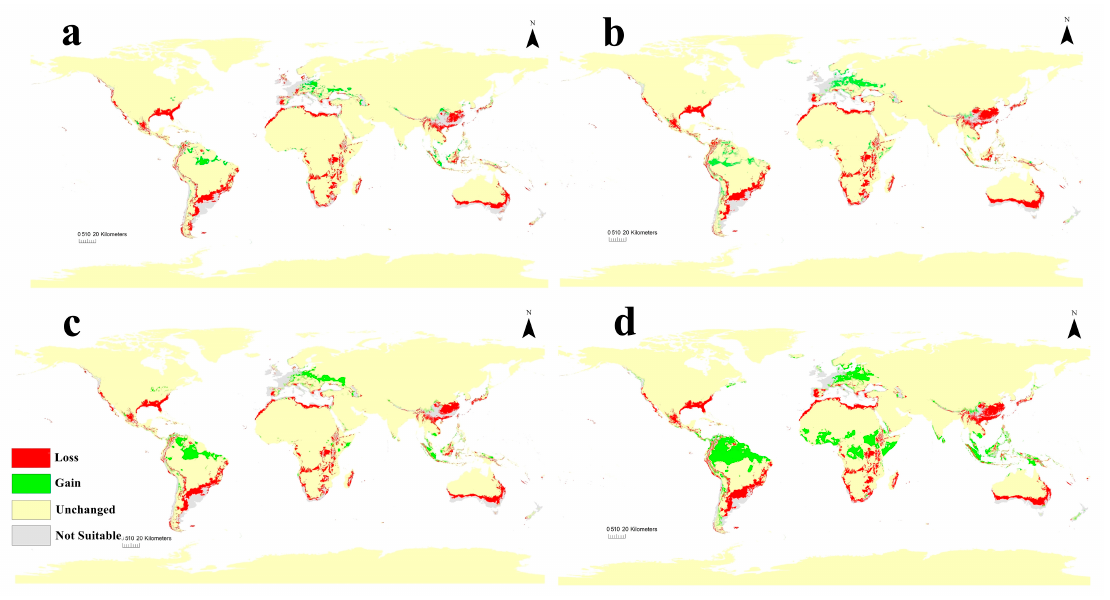
Figure 5. Calibration maps showing gain and loss in habitat suitability of C. albiceps through the four future scenarios against the current status with threshold (>0.5): ( a ) 2050 for RCP 2.6; ( b ) 2050 for RCP 8.5; ( c ) 2070 for RCP 2.6, and ( d ) 2070 for RCP